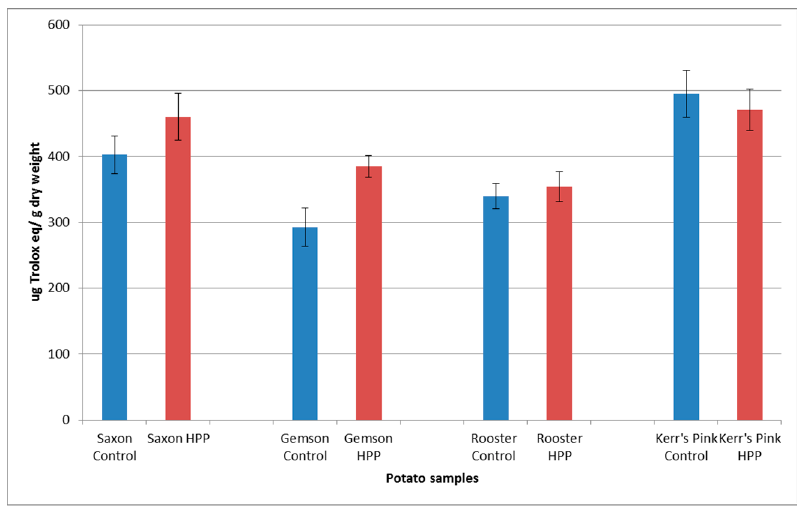
Figure 2. Effect of HPP treatment on antioxidant activity of potatoes as evaluated by DPPH assay expressed as µg of Trolox equivalents per g of potato dry weight. Values presented are the average ±